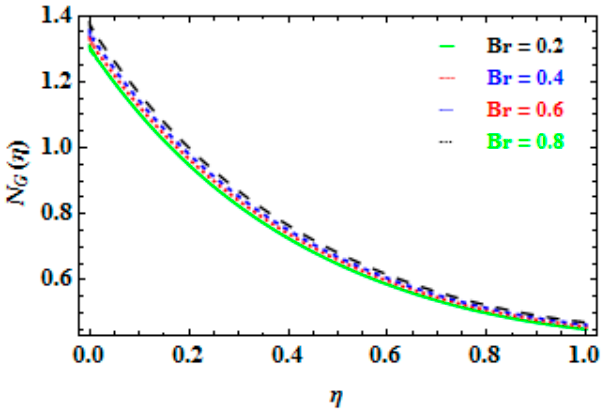
Figure 25. Influence of Br on 𝑁 (cid:3008) ( 𝜂 ).